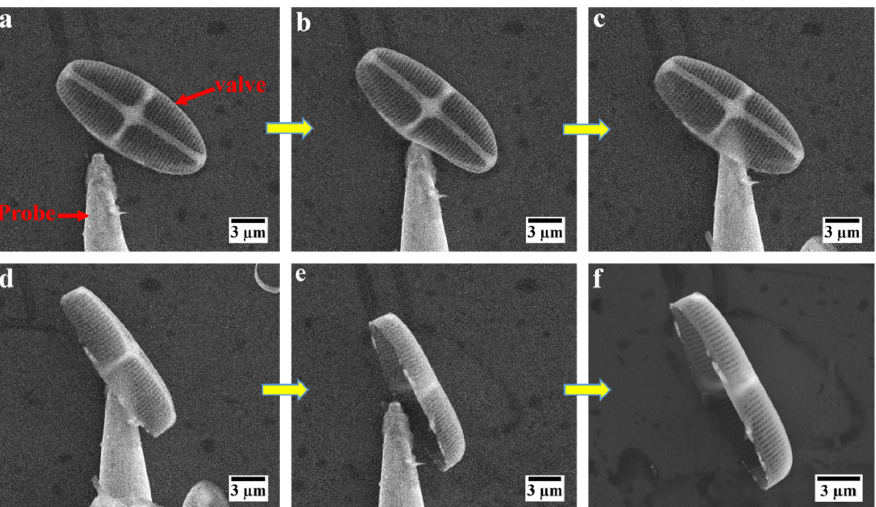
Figure 3. Mechanical manipulation of an isolated valve of diatom C.sp. ( a – f ) SEM image sequence acquired during repositioning of an isolated valve from its flat orientation to standing on its